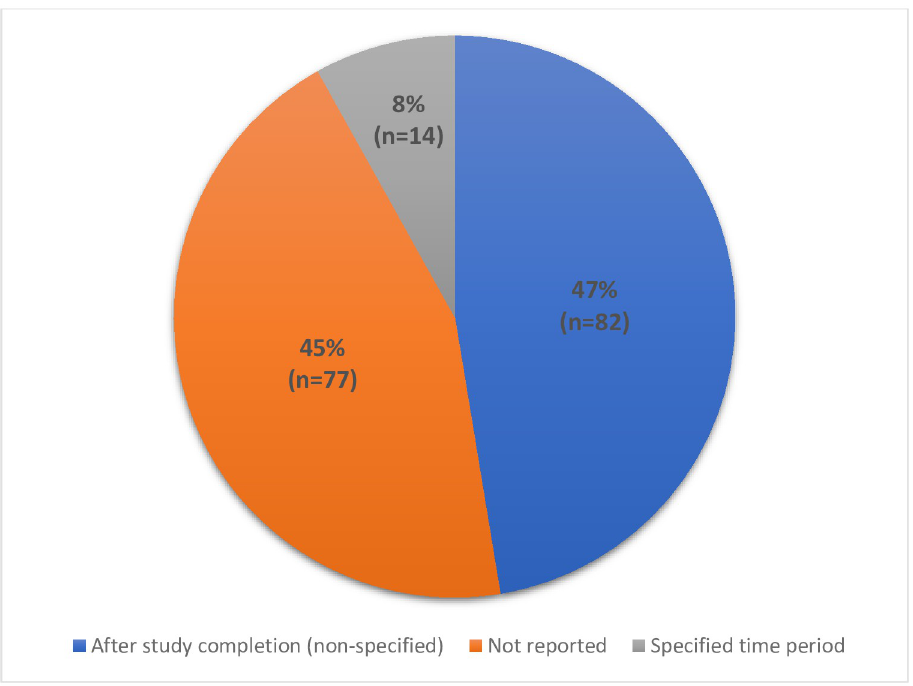
Fig 2. Pie chart of information on timing of when results will be made